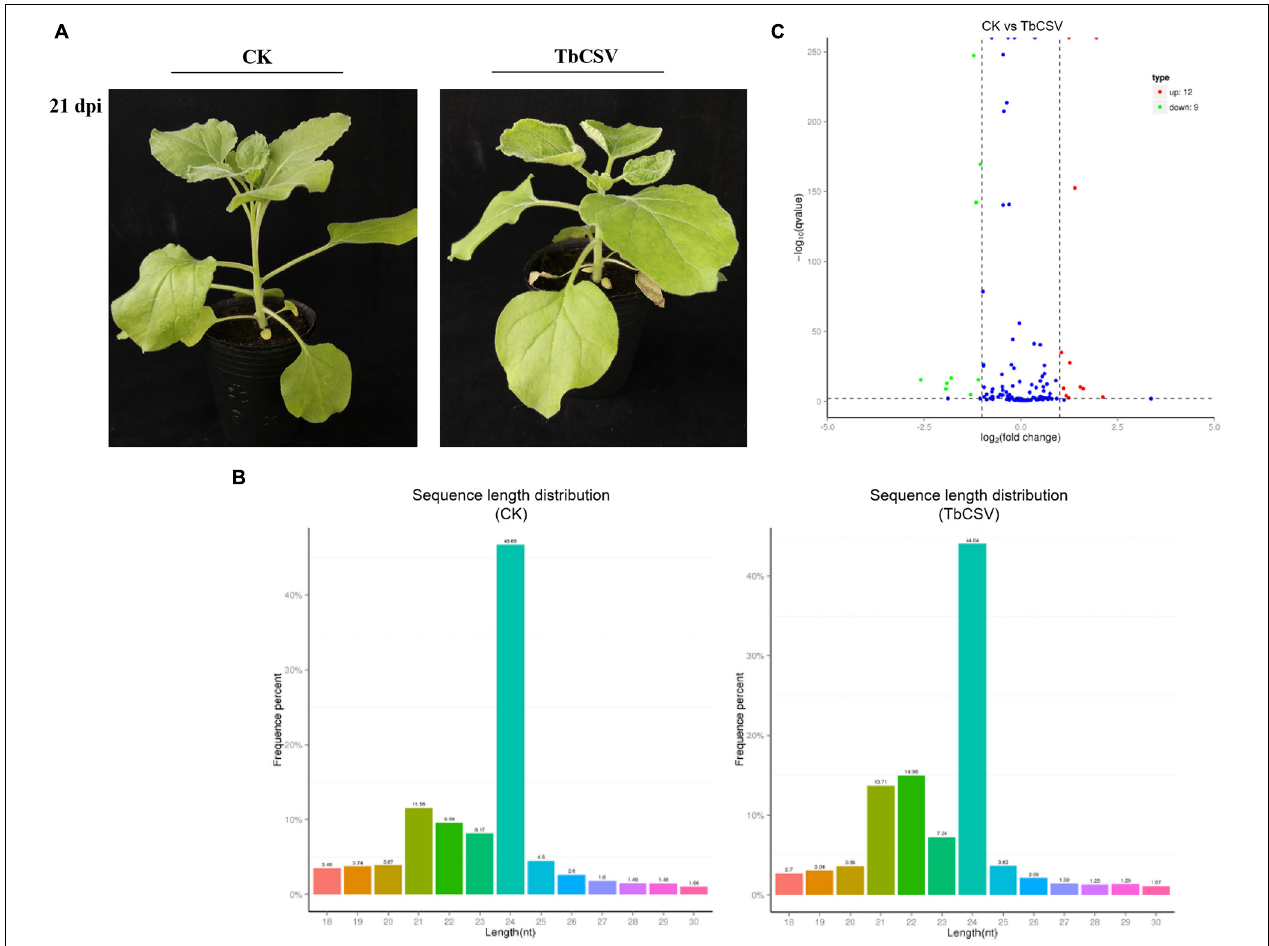
FIGURE 1 | Analysis of small RNA sequencing data. (A) TbCSV symptoms on systemic leaves of N. benthamiana plants at 21 dpi with leaf curling and shrinking. (B) The length distribution of small RNAs after TbCSV infecting N. benthamiana . The abscissa shows the size of miRNAs and vertical axis shows percentage of total small RNAs. (C) Volcano map of differential expression miRNAs in TbCSV infiltrated N. benthamiana . The abscissa shows the fold change difference in the expression of miRNAs in different treatments and control plants, and the vertical axis indicates the adjusted p-adj for the differences in expression. MiRNAs without significant differences are indicated by blue dots, the up-regulated genes by red dots and the down-regulated genes by green dots.